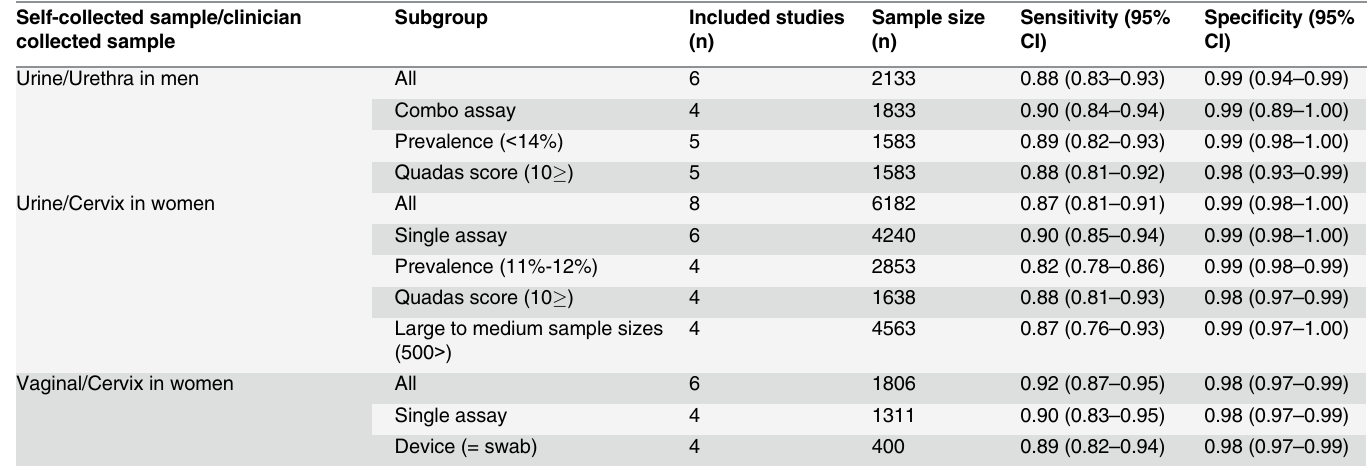
Table 2. Pooled effect size of chlamydia studies using a HSROC random effects model (for sub-groups of 4 studies or more). Self-collected sample/clinician collected